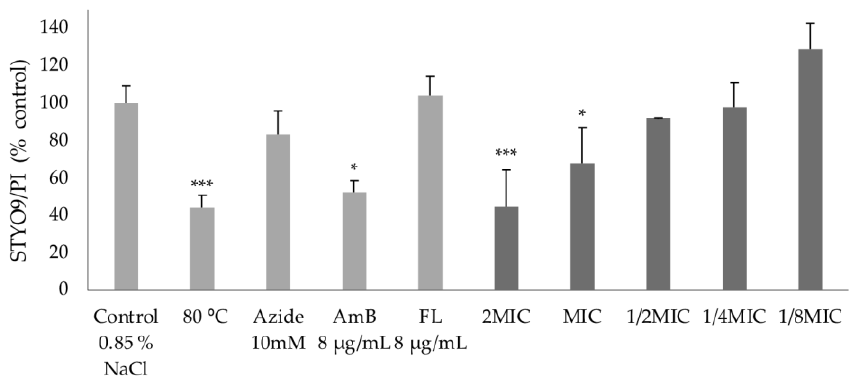
Figure 6. Viability staining of Candida albicans ATCC 10231 cells treated with different concentrations of compound 1 , five min after exposure. Data are shown as mean ± standard deviation of three independent assays. Controls included untreated cells incubated for 20 min at 80 ◦ C, 10 mM sodium azide, amphotericin B (AmB), and fluconazole (FL) at 8 µg/mL. MIC: Minimal inhibitory concentration. * p < 0.05, *** p < 0.001 (one-way ANOVA followed by Dunnett´s test).